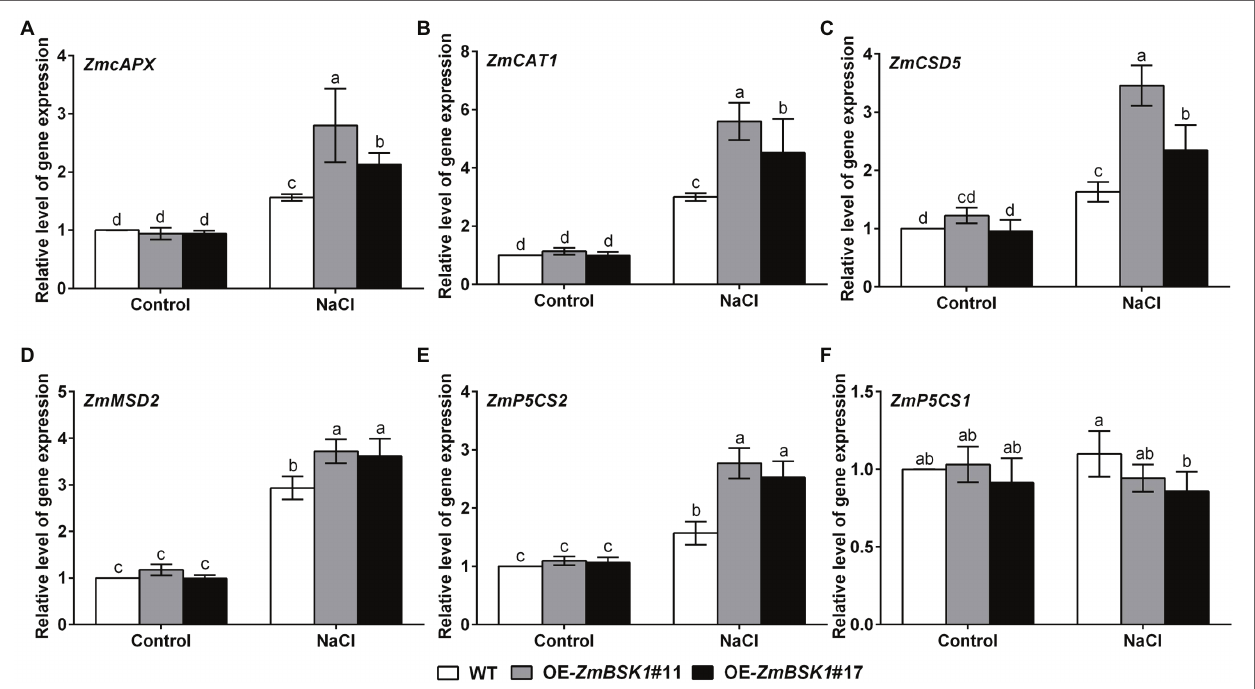
FIGURE 5 | ZmBSK1 positively regulates the expression of stress-related genes in maize under salt stress. The expression levels of stress-related genes ZmcAPX (A) , ZmCAT1 (B) , ZmCSD5 (C) , ZmMSD2 (D) , ZmP5CS2 (E) , and ZmP5CS1 (F) in OE- ZmBSK1 and WT maize plants exposed to salt stress. About 10-day-old maize seedlings were treated with 200 mM NaCl for 6 h, and the expressions were measured by qRT-PCR. ZmActin2 served as an internal control. Error bars in (A–F) represent ±SD ( n = 3). Different letters indicate significant differences at p < 0.05 according to two-way ANOVA (Duncan’s multiple range